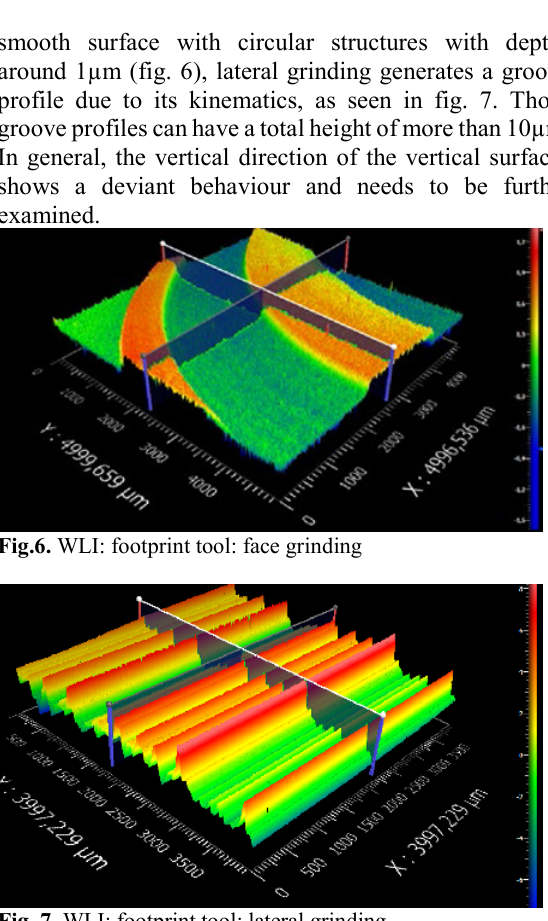
Fig. 7. WLI: footprint tool: lateral